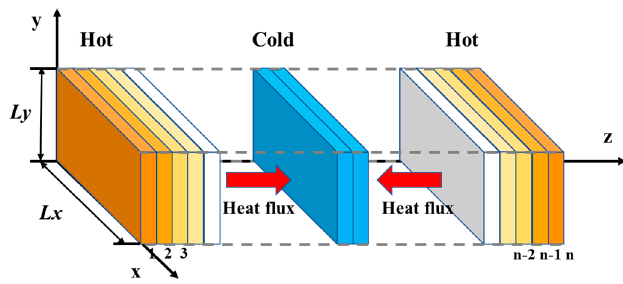
Figure 6. Mechanism model for heat conduction calculation of RNEMD.